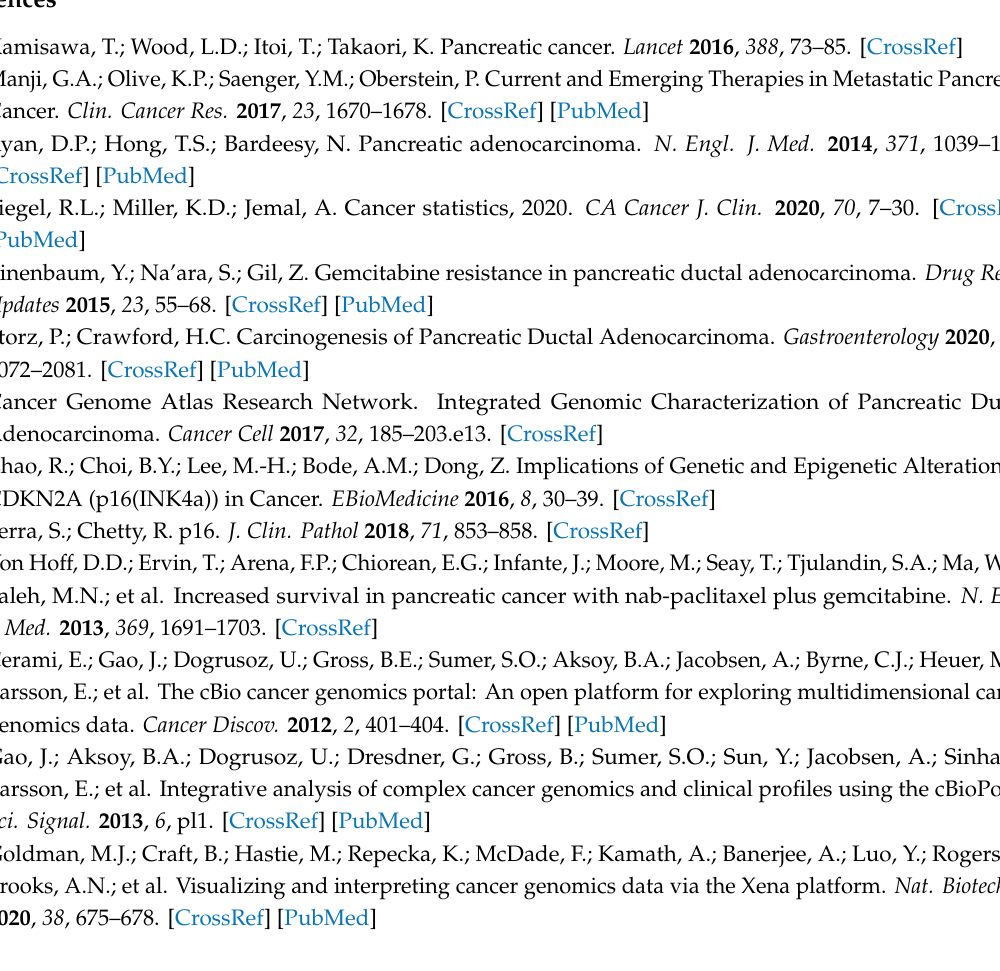
Table S1: Cancer genomics data for cancer patients, Table S2: Chemosensitivity profiles of patient-derived PDAC organoids, Table S3. Di ff erentially expressed genes in CDKN2A-overexpressed CAPAN-1 cells, Table S4. Genes correlated with paclitaxel and SN-38 drug sensitivity in PDAC cell lines, Figure S1: A pan-cancer analysis for the CDKN2A genetic alterations, Figure S2. E ff ect of genetic alterations on CDKN2A mRNA expression in cancers, Figure S3. E ff ect of CDKN2A mRNA expression levels on cancer patients’ overall survival, Figure S4. E ff ect of CDKN2A genetic alterations on cancer patients’ overall survival, Figure S5. E ff ect of CDKN2A genetic alterations on cancer patients’ primary therapy outcome, Figure S6. The functional impact of CDKN2A inactivation in head and neck squamous cell carcinoma, Figure S7. The correlation between CDKN2A copy number variation and mRNA expression levels in pancreatic ductal adenocarcinoma cell lines, Figure S8. The correlation between CDKN2A copy number variation and paclitaxel drug activity in cancer cells, Figure S9. The correlation between CDKN2A copy number variation and SN-38 drug activity in cancer